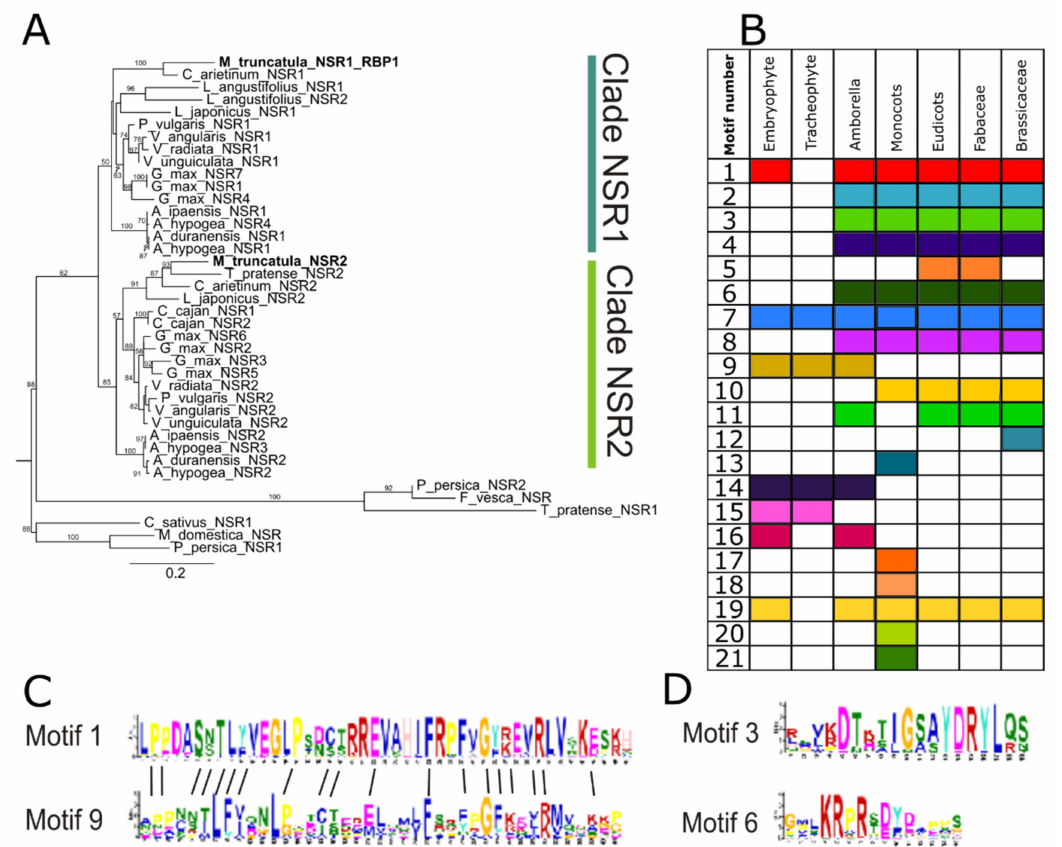
Figure 1. Nuclear Speckle RNA-binding proteins NSR phylogeny of selected eudicot families and motif analysis of NSR proteins in vascular plants. ( A ) Maximum likelihood tree of NSR proteins in Fabaceae; M. truncatula sequences are bolded. Bootstrap values are indicated above branches. ( B ) Protein motifs’ occurrence in land plants. The 21 conserved motifs identified with MEME